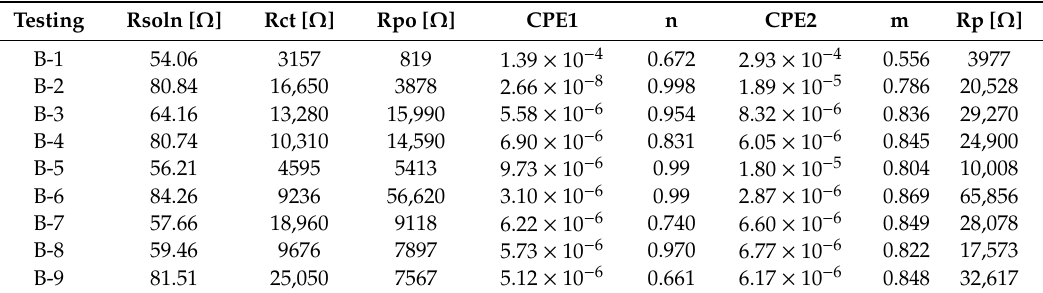
Table 2. Results of the equivalent circuit settings of the EIS impedance results obtained from the aluminum–bronze coatings.